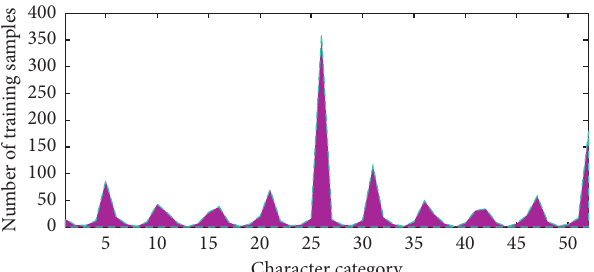
Figure 6: Distribution of the number of character classes in the sample.